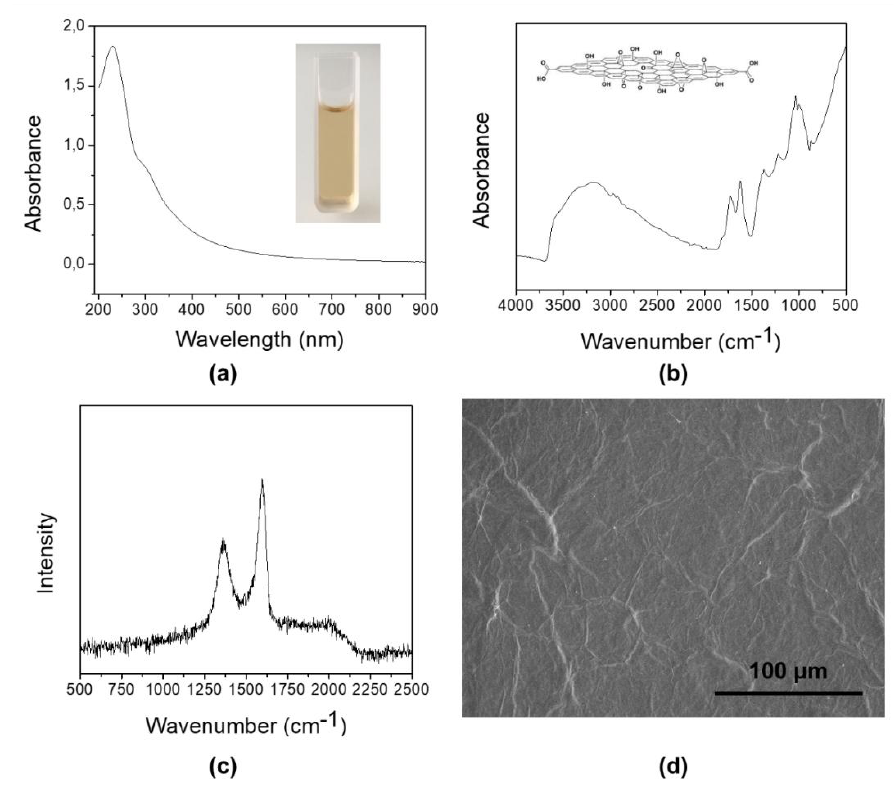
Figure 2. ( a ) UV-vis spectroscopy of a dilute aqueous suspension of graphene oxide. The inset shows the visual appearance of the suspension. ( b ) FTIR spectrum of graphene oxide. The inset shows a typical representation of a GO layer decorated with different oxygen-based functional groups (hydroxyls, carboxylic acids, ketones, ethers). ( c ) Raman spectrum of graphene oxide. ( d ) Scanning electron microscopy (SEM) image of a multilayer graphene oxide deposited on a silicon substrate from its aqueous suspension.